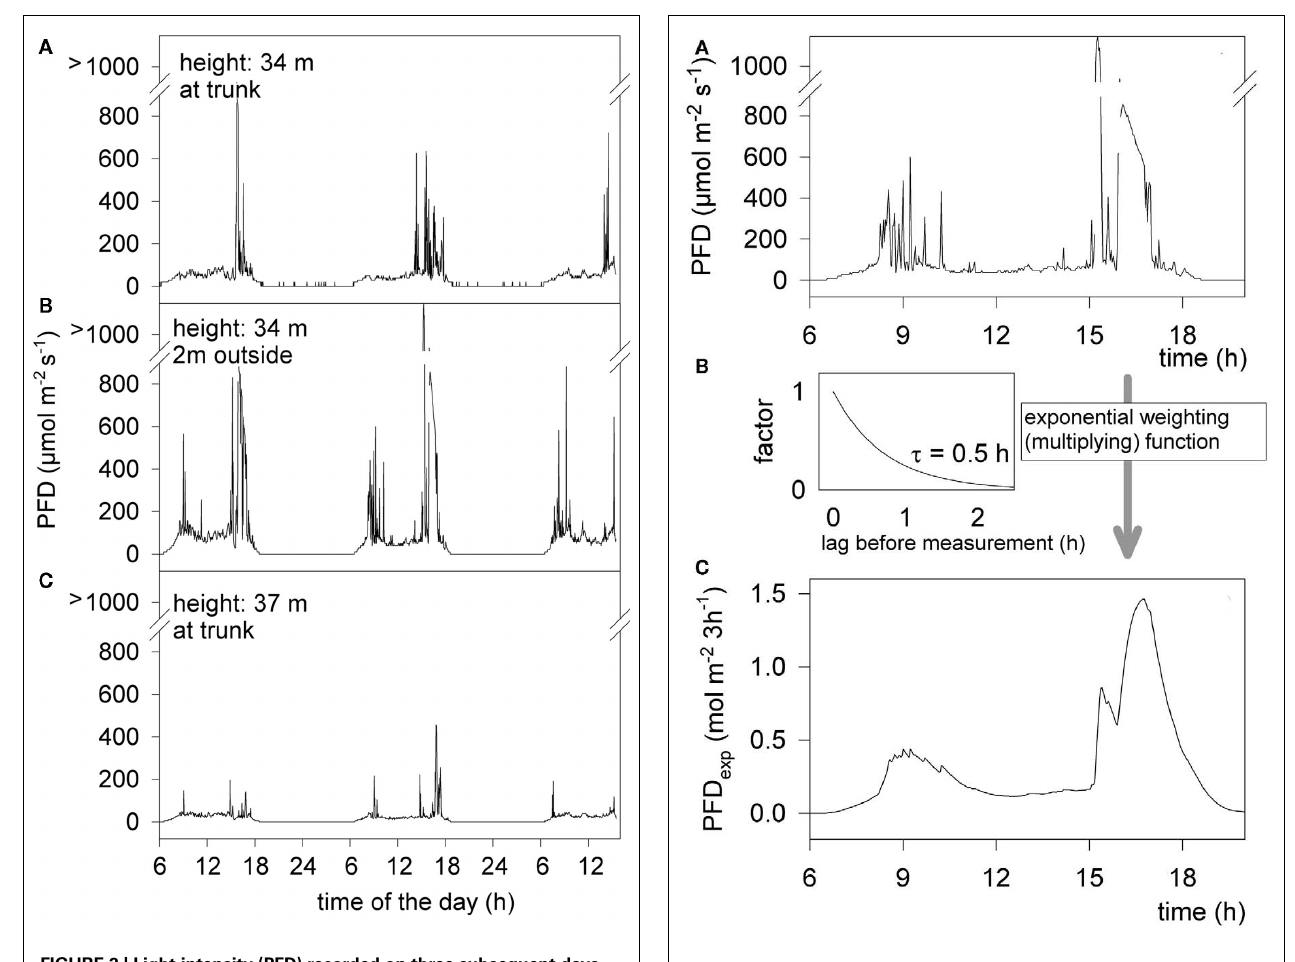
FIGURE 3 | Example of light intensity (PFD) during the day course and the way of calculating an exponentially weighted integral over a 3h time window. (A) Momentary (ambient) PFD measured by a light sensor in 2min intervals.The sensor was located just above a dense stand of Maxillaria alba , 34m above the ground in the canopy. (B) Exponential weighting function, with a half-time ( τ ) of 30min. Light intensities measured before are multiplied (weighted) with this factor. (C) Exponentially weighted and integrated light intensity (PFD exp ) over a 3h window, determining the “recently” perceived photon flux. Insert: integrated light intensity over the same day course for